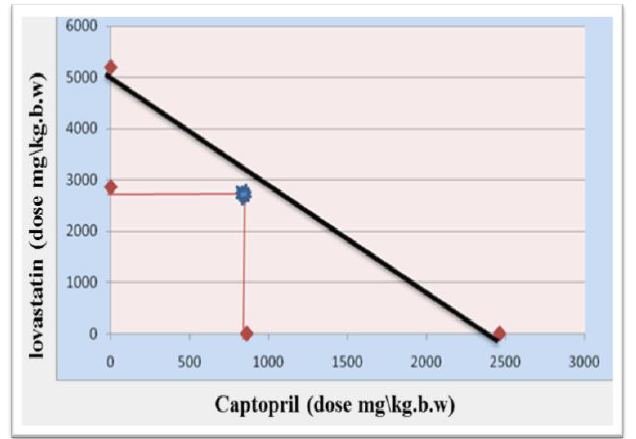
Figure 3. Isobolographic for chronic toxicity interaction between captopril and lovastatin